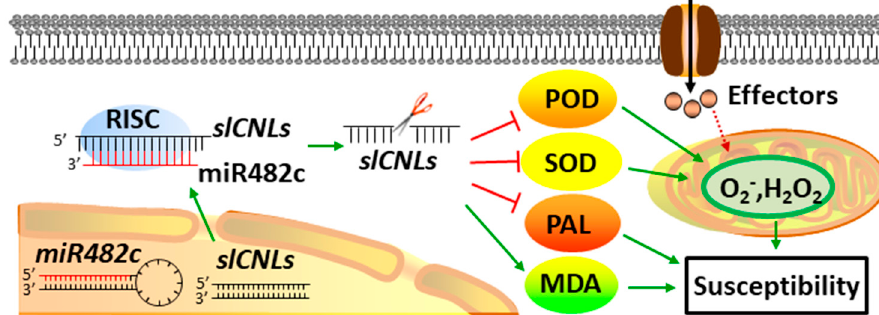
Figure 5. The regulation network of miR482c- nucleotide binding sites and leucine-rich repeat (NBS-LRR) involved in tomato resistance. Overexpressing miR482c in tomato enhanced plant susceptibility to late blight by reducing the targeted SlCNL genes, accompanied by lower POD, SOD, and PAL activities and higher MDA content. Red lines represent negative regulated gene or function, while green arrows represent positive regulated gene or function. Red dotted arrow indicates the effectors produced by pathogens invading the host plant acts on the production of ROS by a direct or indirect way.